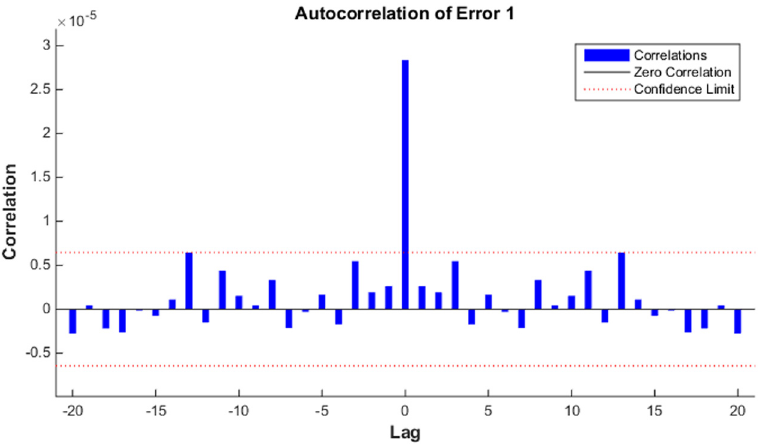
Fig 5. The error autocorrelation plot of target series. The correlations, except for the one at zero lag, fall approximately within the 95% confidence limits around zero, so the model seems to be adequate.